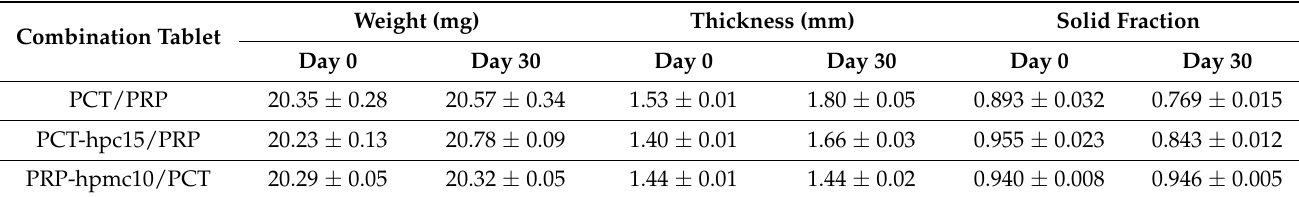
Table 6. Weight, thickness and solid fraction of tablets before and after the stability